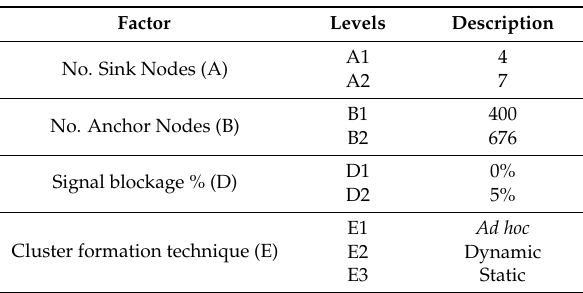
Table 3. Experimental factors and their